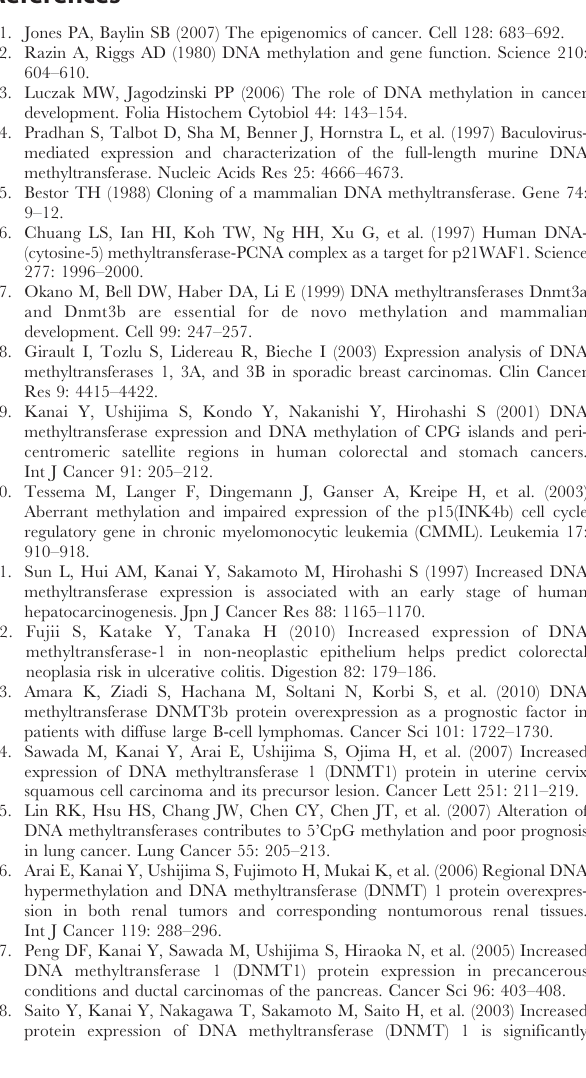
Figure S1 Kaplan-Meier survival analysis of association between DNMT1 expression and OS and DFS in different subgroups.